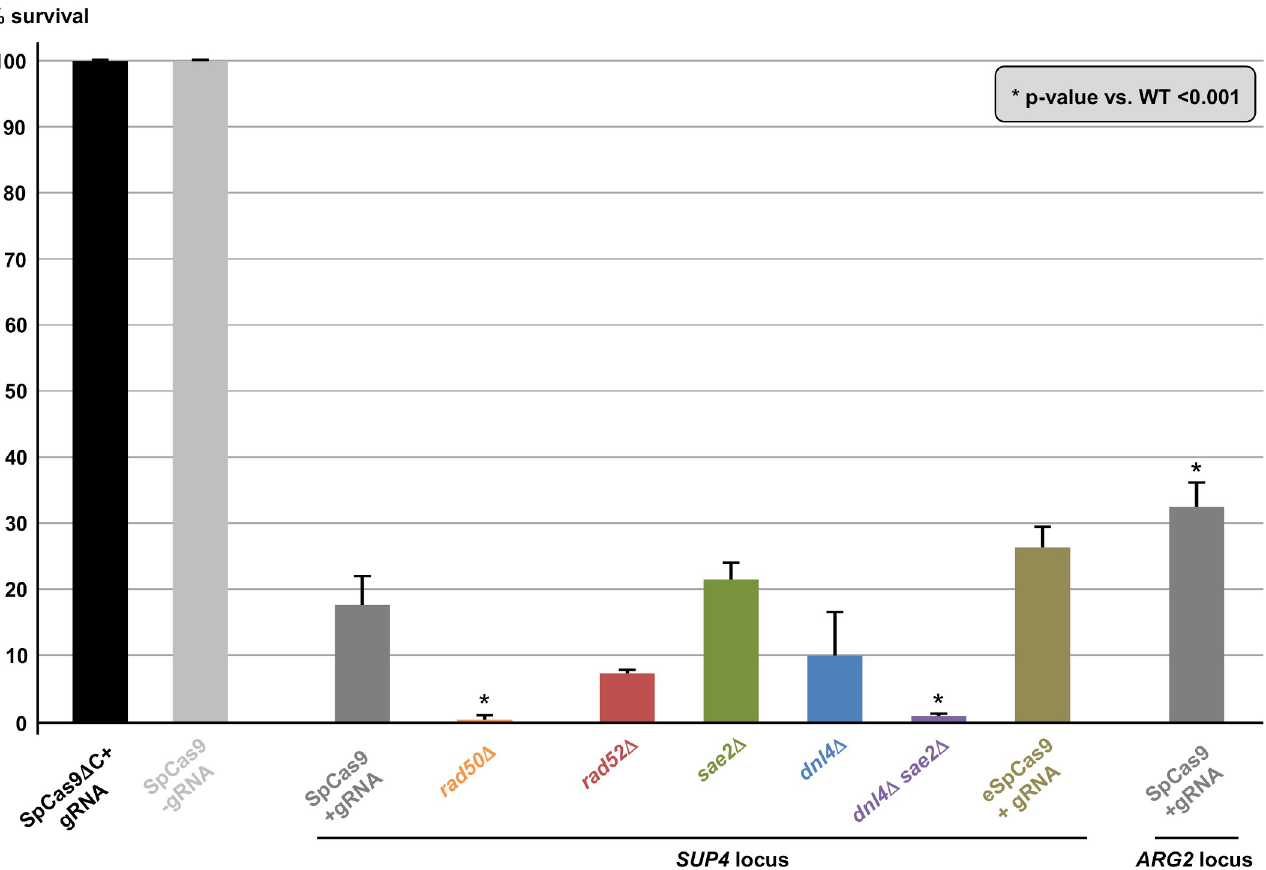
Fig 2. Yeast survival to Cas9 induction. For each strain, the same number of cells were plated on galactose and glucose plates and the survival was expressed in CFU number on galactose plates over CFU number on glucose plates. The mean and the 95% confidence interval are plotted for each strain. Significant t-test p- values when compared to wild-type Sp Cas9 survival are indicated by asterisks. See Materials & Methods for statistics.